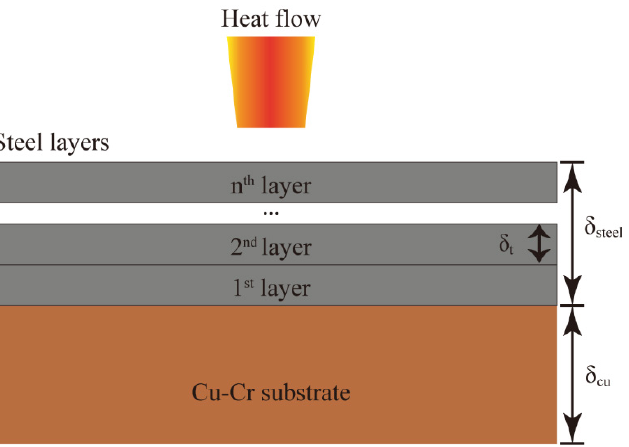
Figure 1. The schematic of fabricating the steel on the CuCr substrate layer by layer, where δ cu , δ steel , and δ t represent the thickness of the CuCr substrate, the total thickness of steel coatings and the thickness of single layer steel coating, respectively.